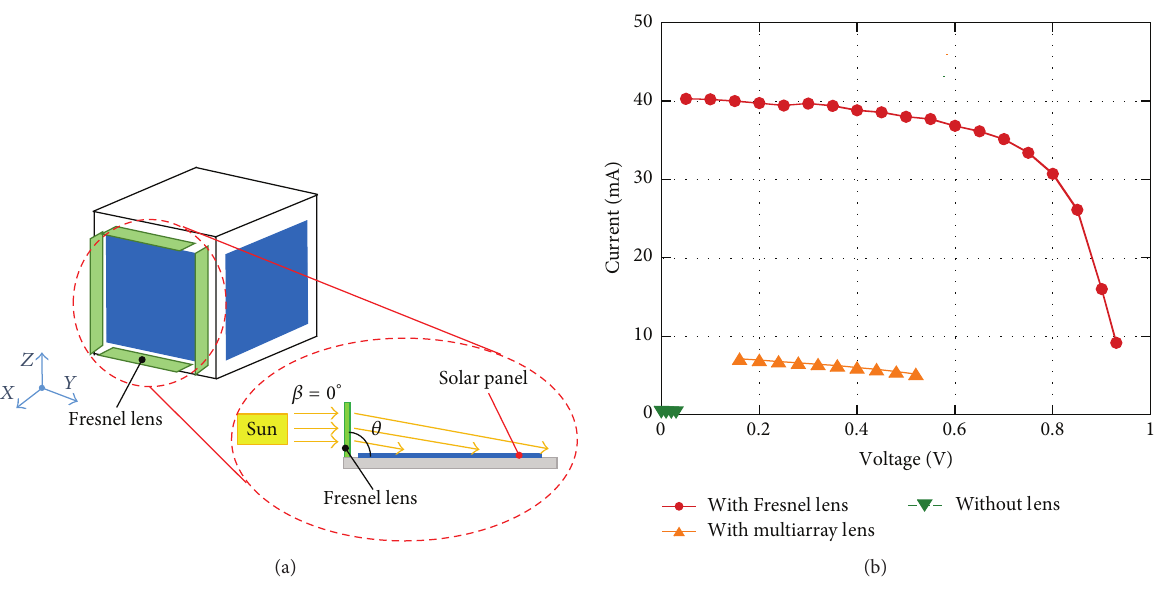
Figure 5: Solar energy collection system using Fresnel lens